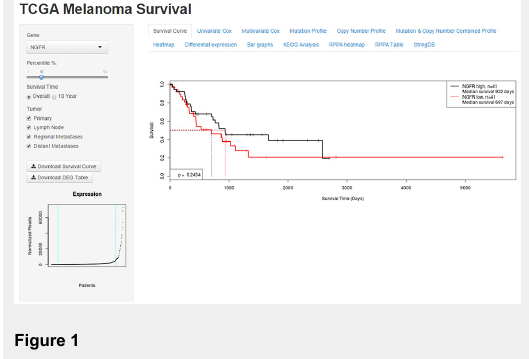
Snapshot of UZH Cancer Browser. Left panel shows selectable parameters for gene, patient percentile, survival time and tumor type. Normalised expression of NGFR accross all patients can be seen in the scatterplot in the bootom left corner. In the main panel of the webtool, tabs for the analysis modules can be selected for visualisation. In this snapshot the survival curve module is selected and the Kaplan-Meier plot is shown.